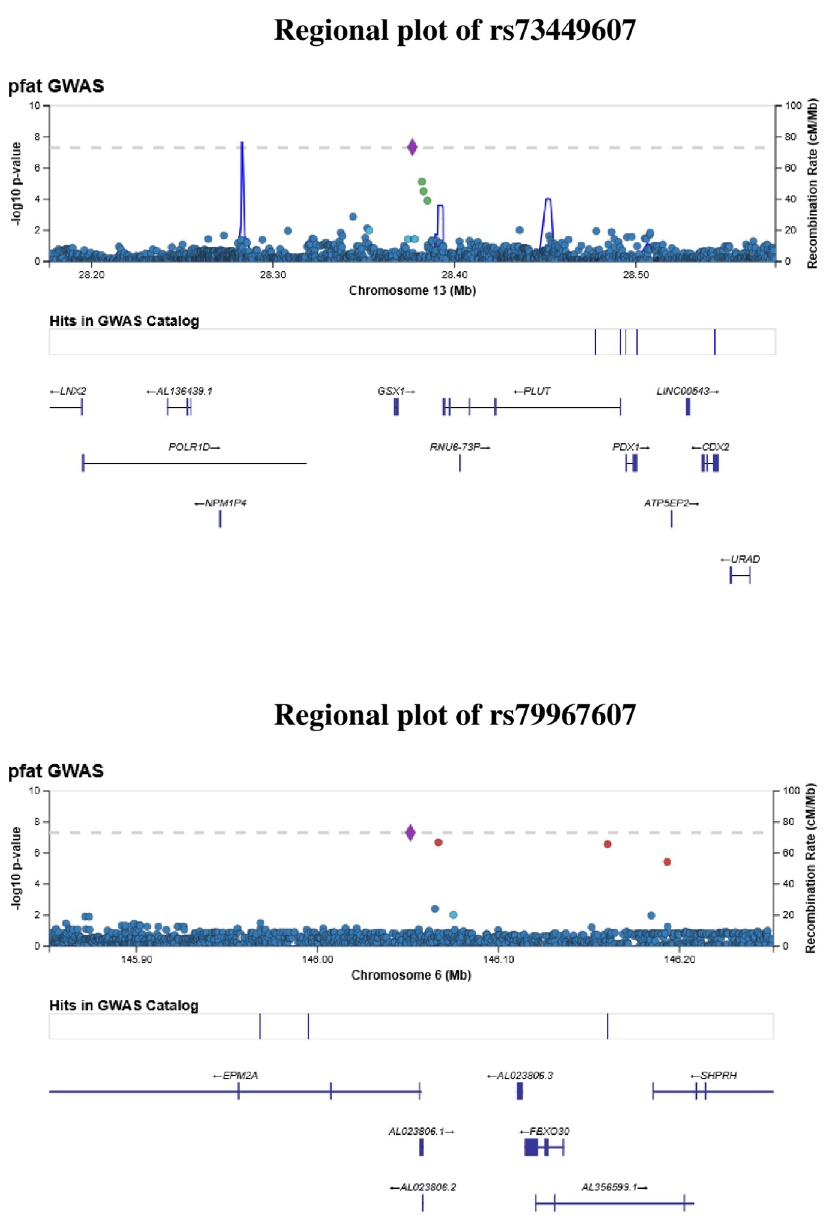
Fig 2. Regional plots of SNP P-values in a +/-200 kb window around rs73449607 and rs79967607. The X-axis shows the chromosome and physical location (Mb), the left Y-axis shows the negative base ten logarithm of the P- values, and the right Y-axis shows recombination activity (cM/Mb) as a blue line. Positions, recombination rates, and gene annotations are according to NCBI’s build 37 (hg 19) and the 1000 Genomes Project Phase 3 multiethnic data